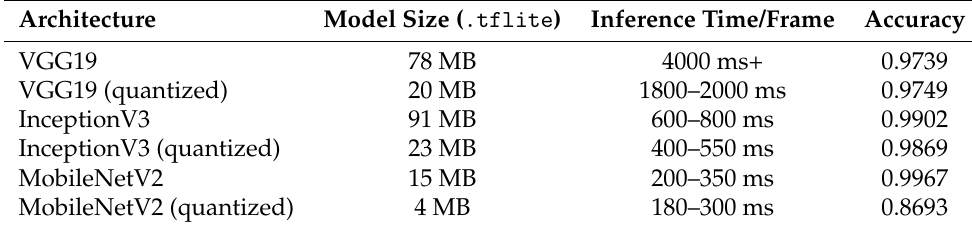
Table 3. Comparison of the trained